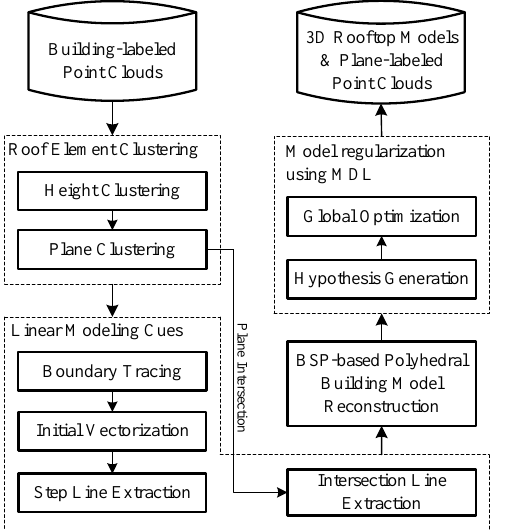
Figure 1. Illustrated workflow of proposed 3D rooftop modelling